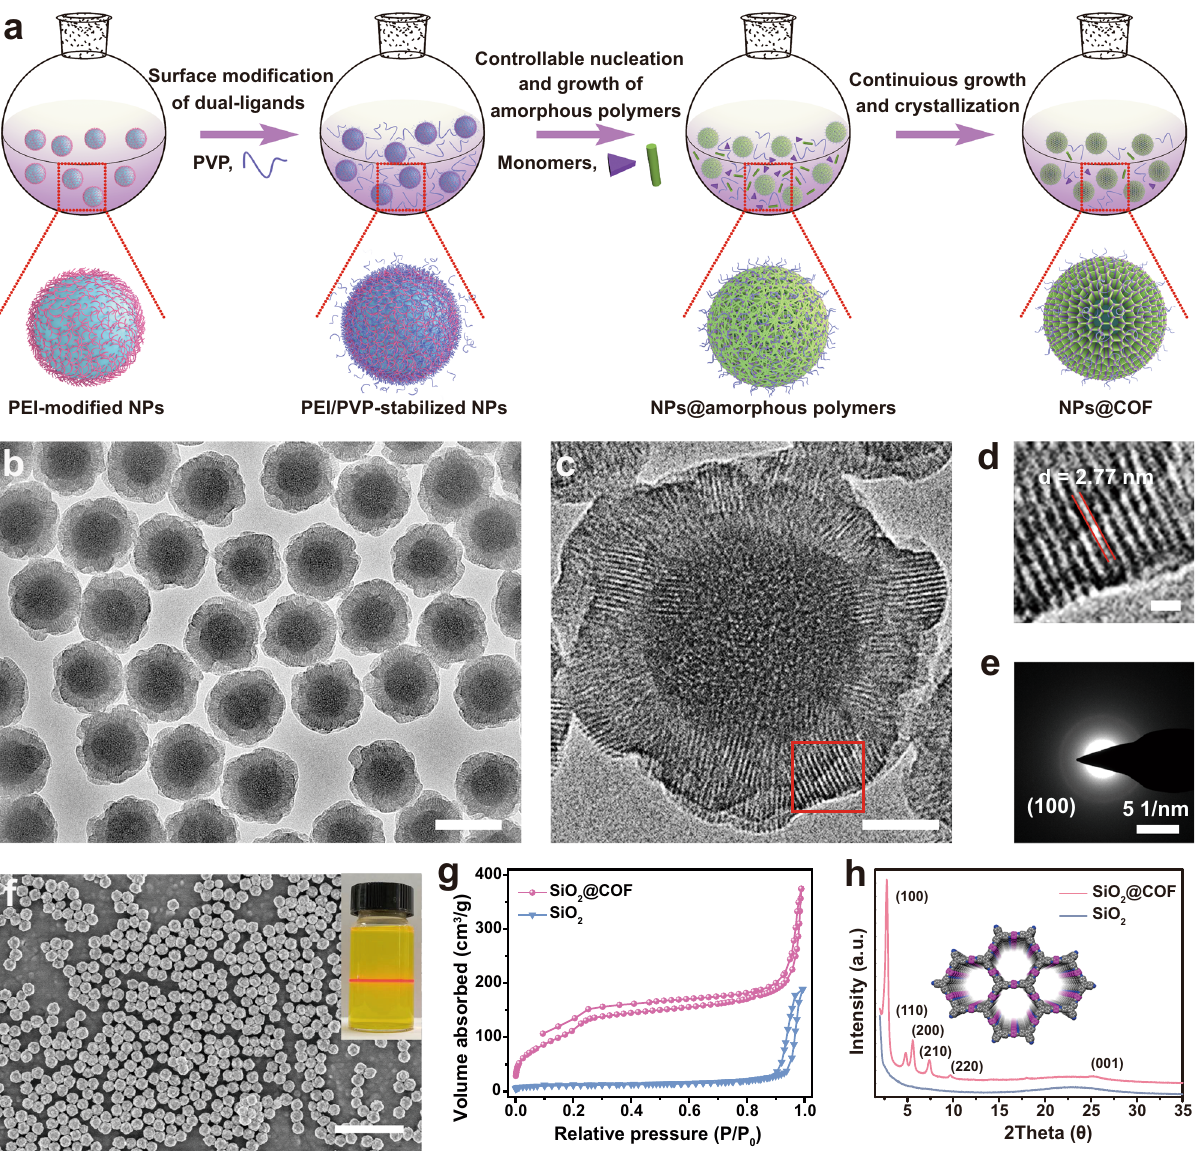
Fig. 1 Synthesis and characterization of core-shell SiO 2 @COF. a Schematic illustration of the preparation of monodisperse COF-coated SiO 2 nanoparticles. b , c TEM images of the obtained SiO 2 @COF nanocomposites. d HRTEM image of the COF shell from the area of red square in ( c ). e The corresponding selected area electron diffraction image taken from the COF shell. f SEM image of SiO 2 @COF nanocomposites. Inset is the colloid dispersion of as-prepared SiO 2 @COF after 1 month storage. g Nitrogen-sorption isotherms and ( h ) XRD patterns of the bare SiO 2 and SiO 2 @COF nanocomposites. Scale bars are 200 nm in ( b ), 50 nm in ( c ), 5 nm in ( d ), and 1 μ m in ( f ). A representative image of three replicates from each group is